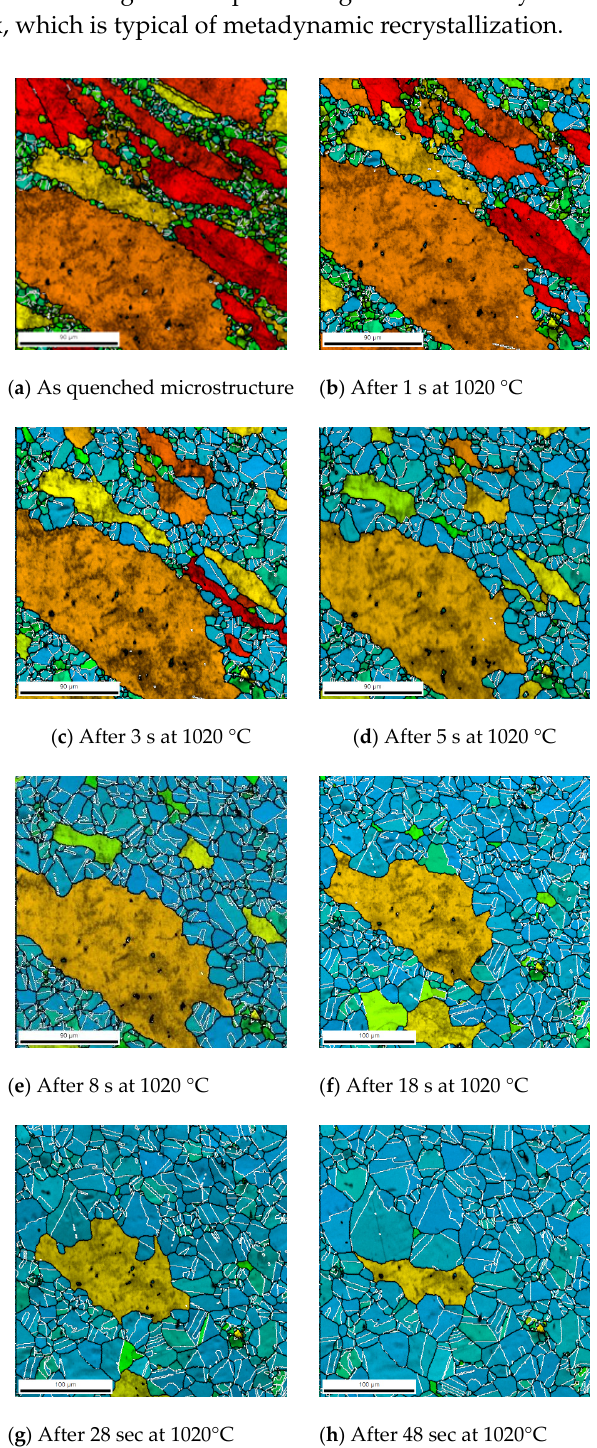
Figure 5. Microstructure evolution of sample B (initial DRX volume fraction = 26%) after successive post ‐ dynamic annealing steps at 1020°C (cumulated holding times are indicated below each micrograph). Intragranular misorientation GOS maps superimposed with the Pattern Quality map. Scale bar: 90 or 100 μ m. Grain boundaries (>15°) in black and twin boundaries (60° <111>) in white. GOS color ‐ coding from 0 to 6.5°: .